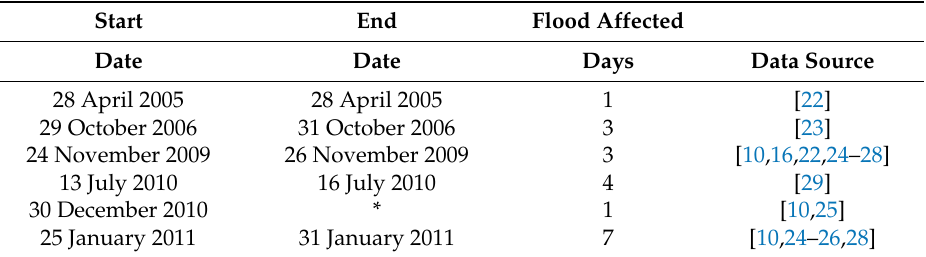
Table 1. Major flood events observed over Jeddah city in